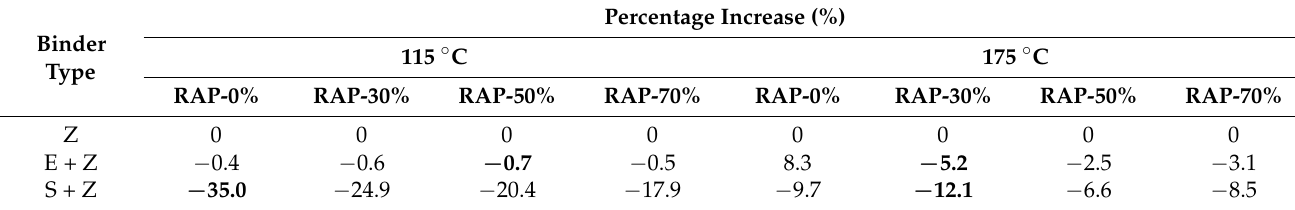
Table 4. Percentage increase in apparent viscosity caused by the WMA